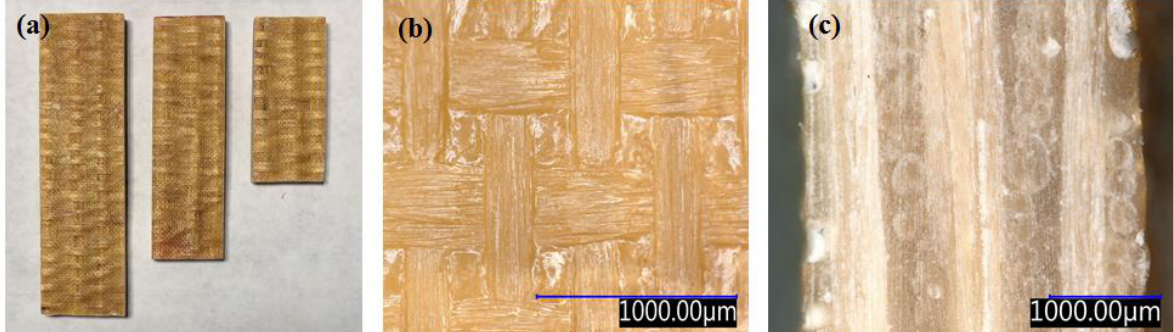
Figure 6. Photographs of the prepared test specimens using an optical microscopy: ( a ) photography of full-scale specimens, ( b ) micrograph at 200×, ( c ) transverse cut seen at 100×.